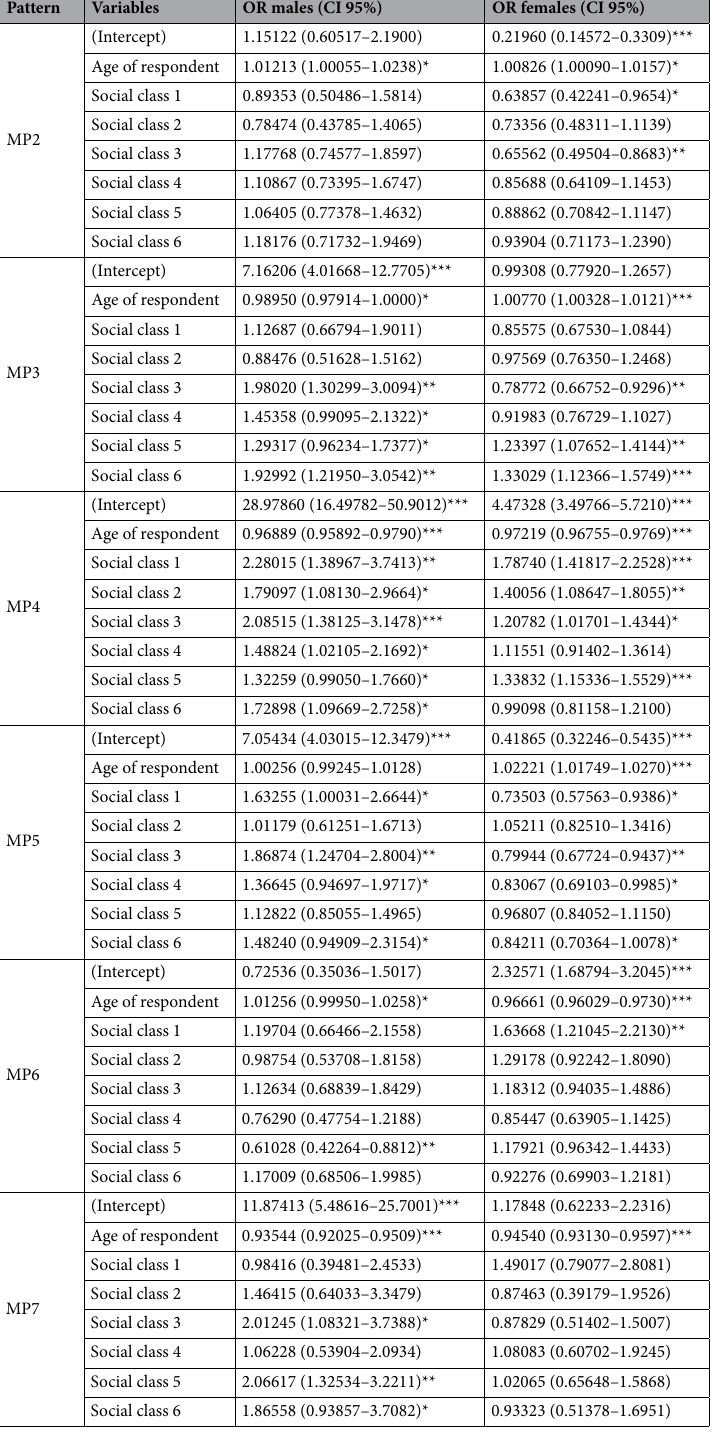
Table 2. Multinomial regression models by gender group. Statistically significant coefficients at the level: 0.001***, 0.01**, and